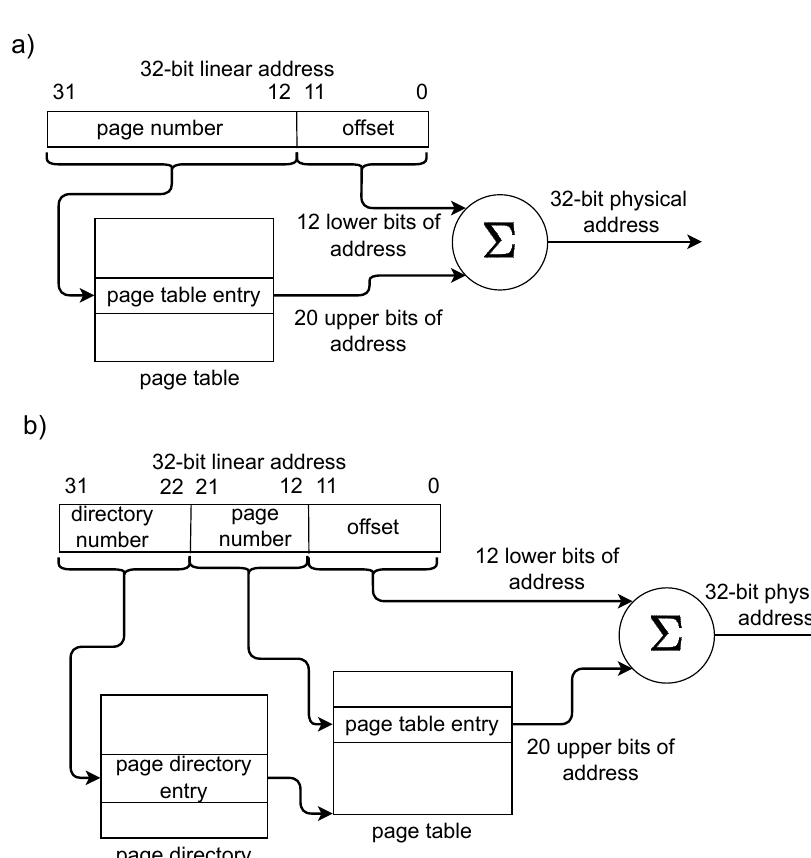
Figure 2. Translation of linear (virtual) addresses into physical addresses with paging (in a